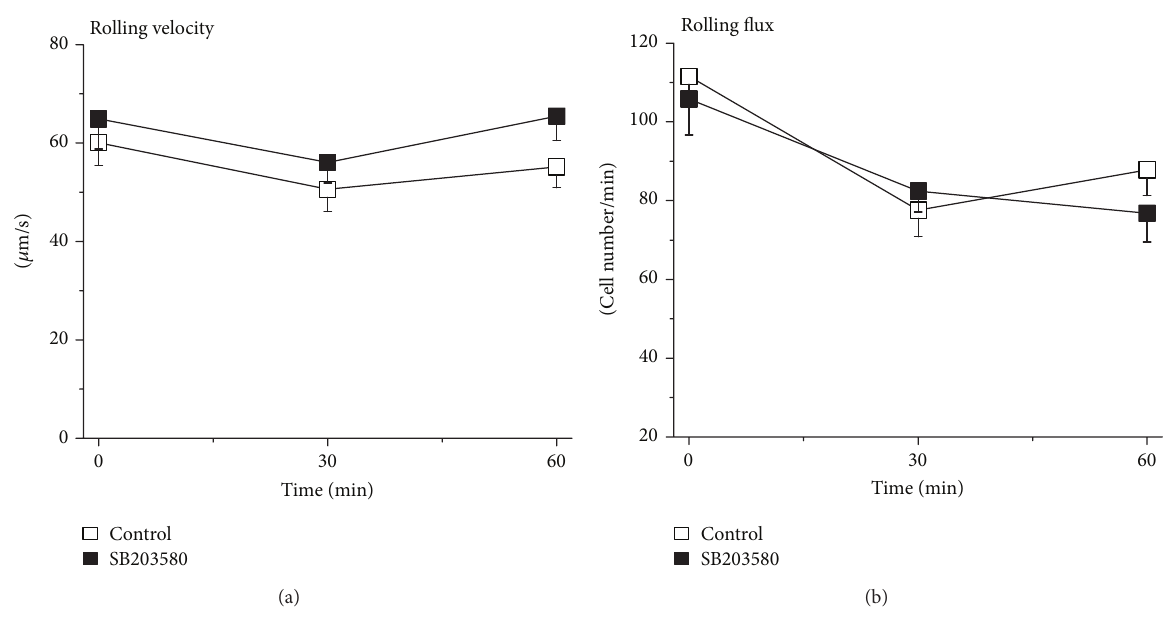
Figure 1: Effect of SB203580 on KC-induced neutrophil rolling. (a) Time course of the velocity of neutrophil rolling ( 𝜇 m/sec) triggered by KC in the absence (control, white) and in the presence (black) of p38 MAPK inhibitor SB203580 (100nM) 30 min prior to and 60min following the placement of KC-containing gel. Data are means ± SEM ( 𝑛 = 5 ). (b) Time course of the flux of rolling neutrophils (cells/min) triggered by KC in the absence (control, white) and in the presence (black) of p38 MAPK inhibitor SB203580 (100nM) 30min prior to and 60min following the placement of KC-containing gel. Data are means ± SEM ( 𝑛 = 5